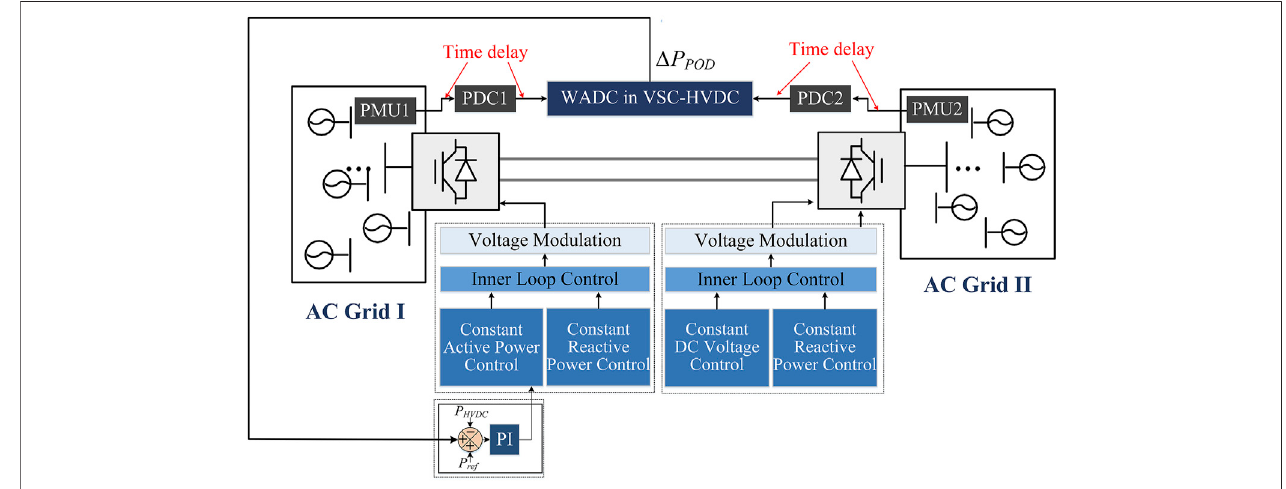
FIGURE 1 | System diagram of VSC-HVDC.